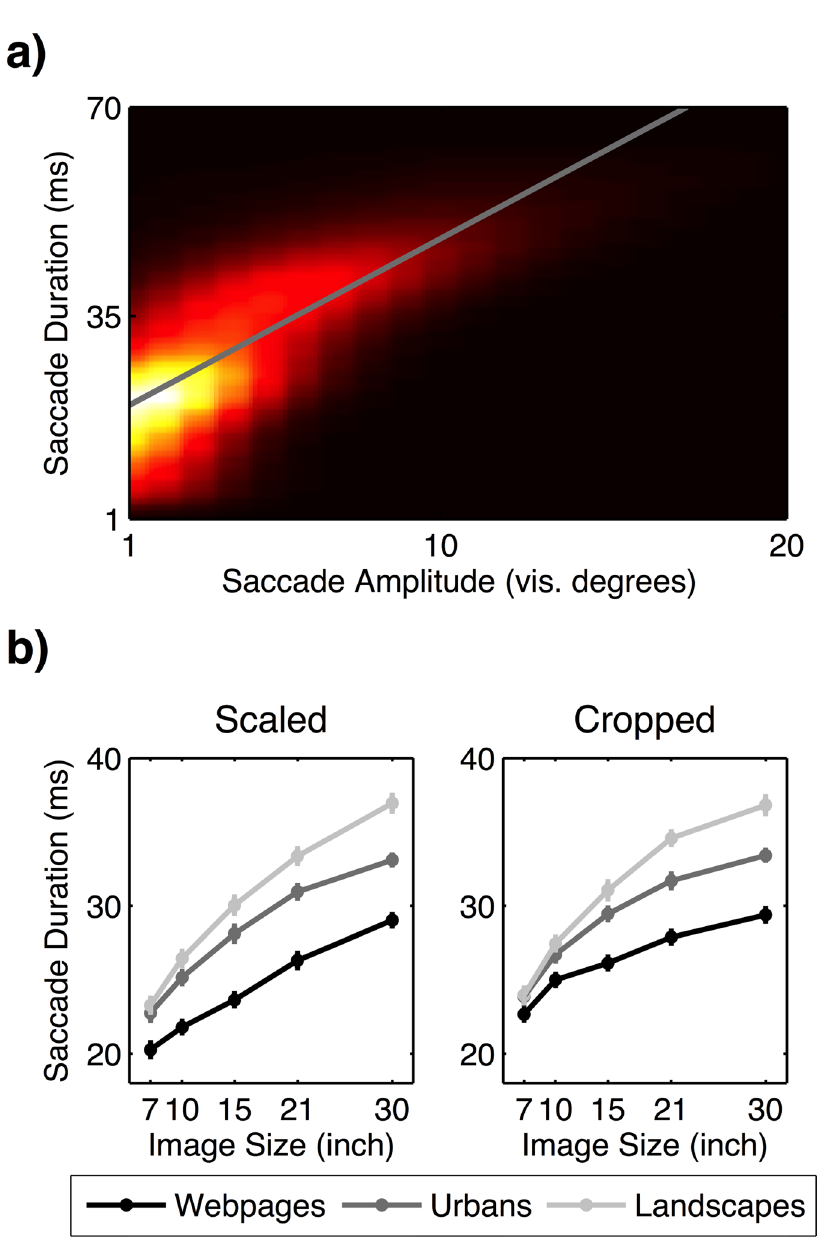
Figure 9. ( a ) Positive correlation between the amplitude and duration of a saccade. ( b ) The increase of the mean saccade duration across image sizes depending on image category and condition (scaled vs. cropped). Error bars indicate standard error of the